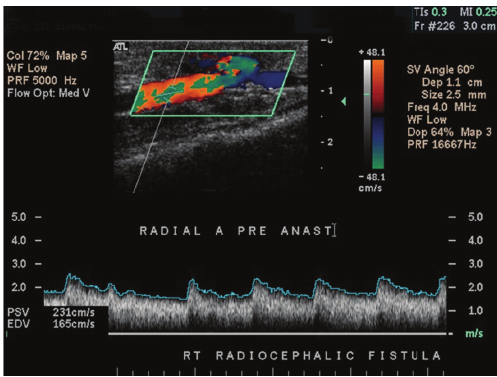
Figure 3: The radial artery just proximal to a Brescia-Cimino fistula demonstrates spectral broadening and diastolic flow seen characteristically in arterial beds with low resistance outflow in addition to elevation of both PSV and EDV. In the absence of dialysis access, a normal radial artery will exhibit triphasic waveforms with no spectral broadening and PSV > 40cm/sec.